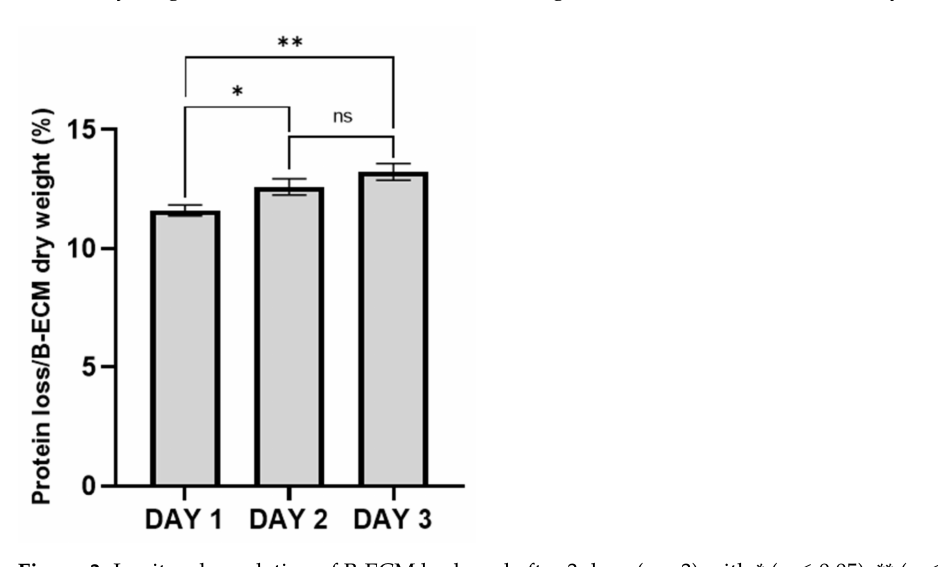
Figure 3. In vitro degradation of B-ECM hydrogel after 3 days ( n = 3) with * ( p ≤ 0.05), ** ( p ≤